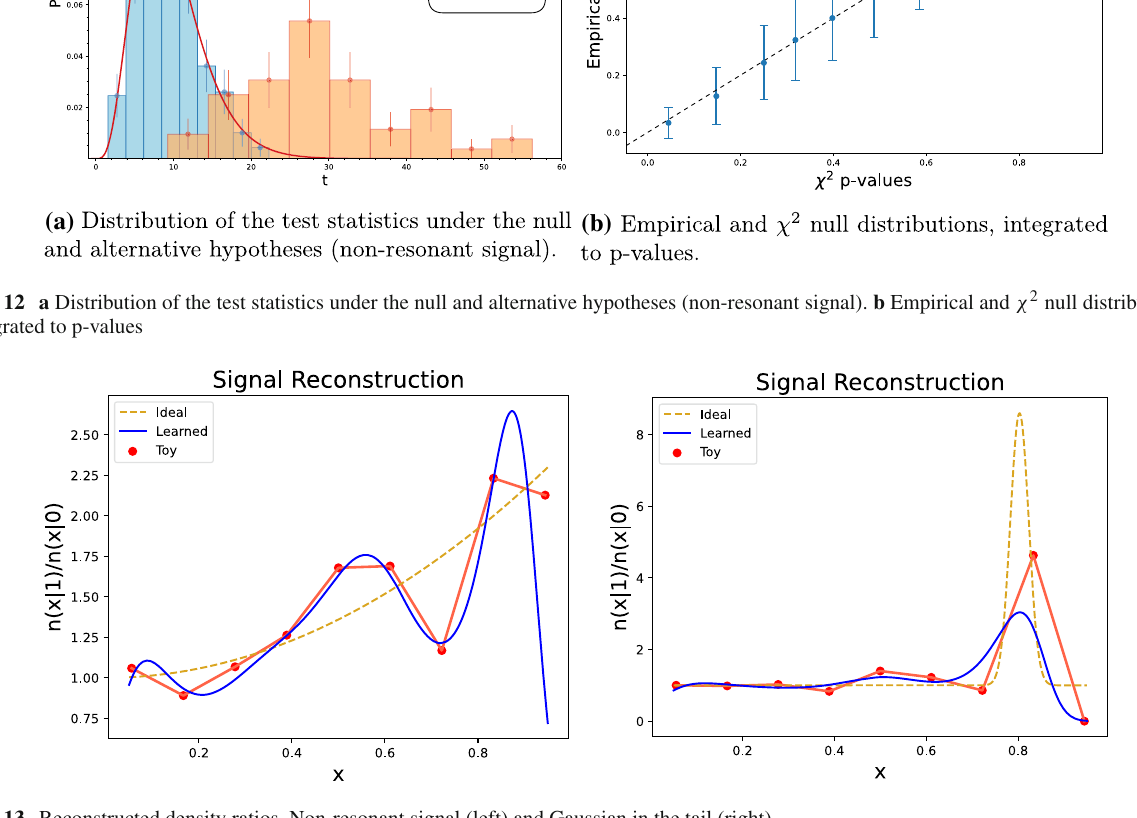
Fig. 13 Reconstructed density ratios. Non-resonant signal (left) and Gaussian in the tail